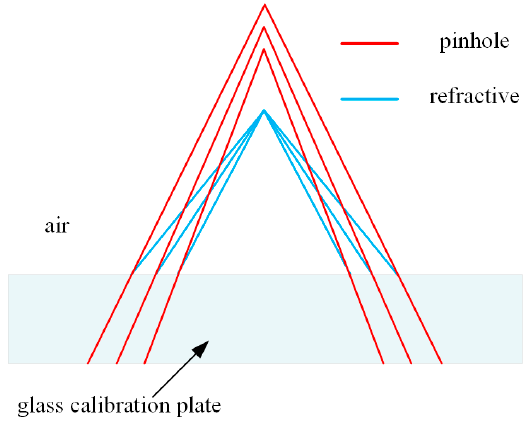
Figure 3. Schematic of imaging through glass using the pinhole and refractive projection model.